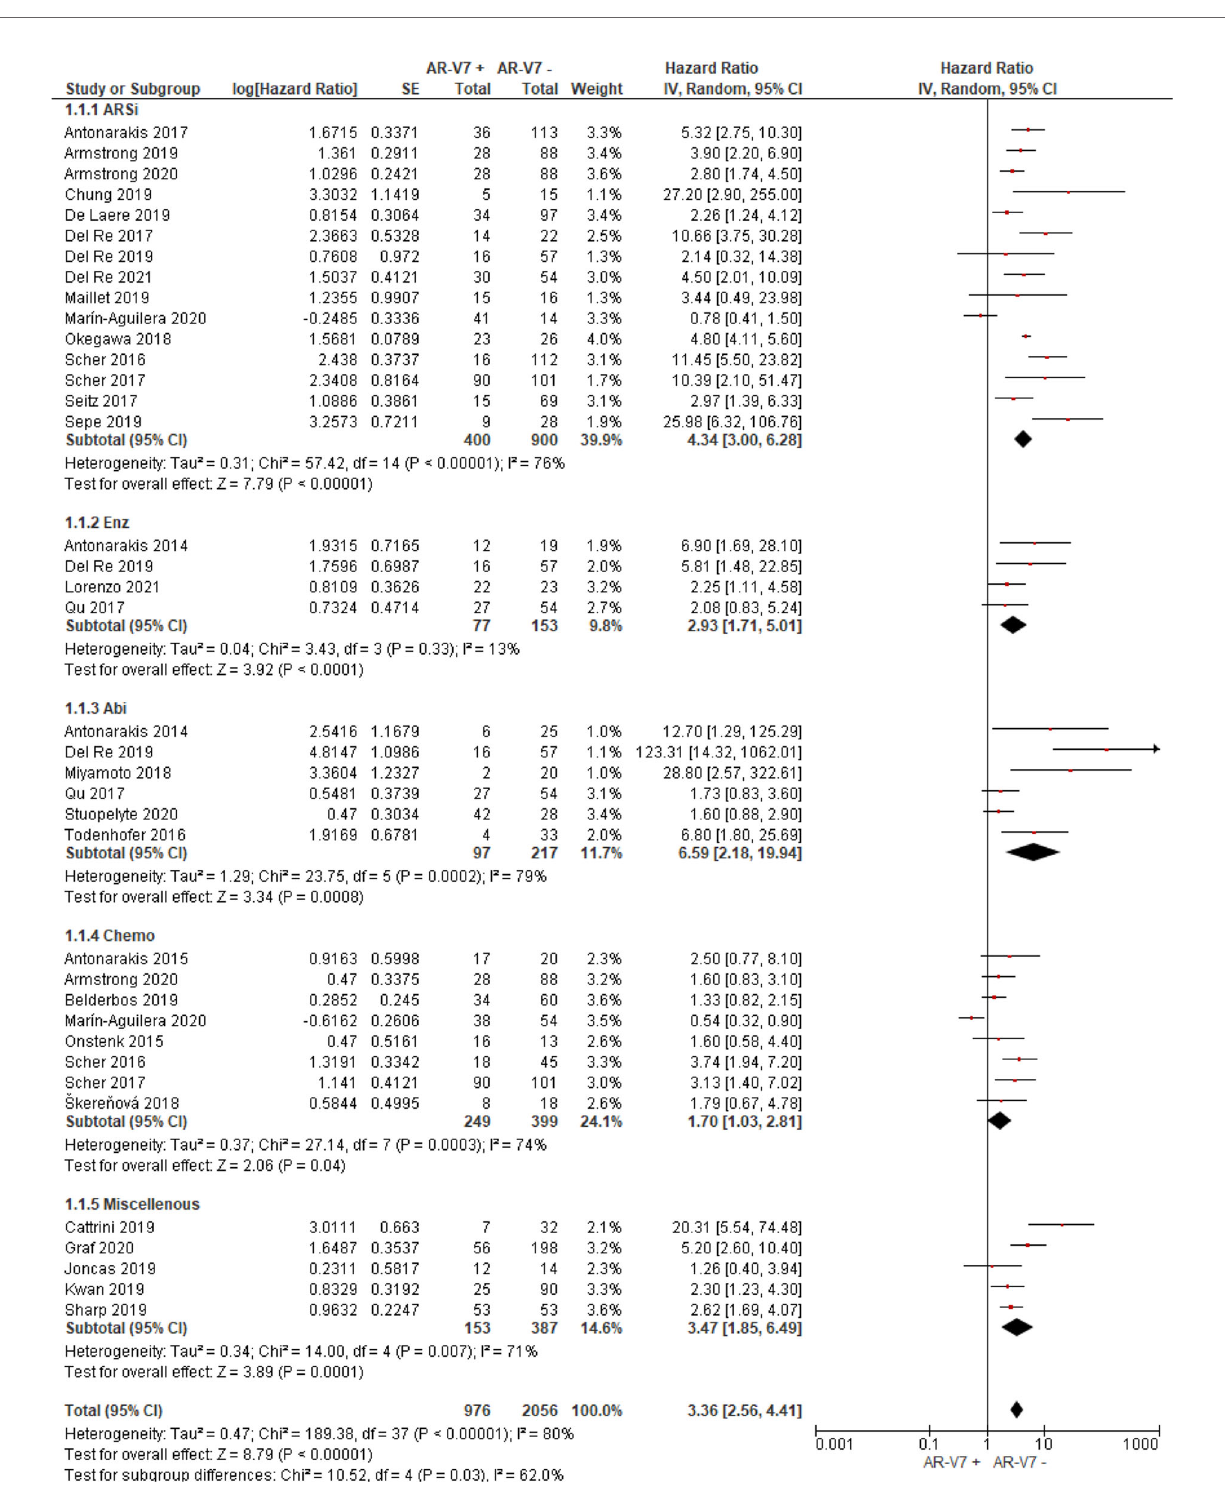
FIGURE 2 | Forest plot of hazard ratios (HRs) for association of liquid biopsy AR-V7 status with overall survival (OS) in all included studies. Pooled HRs were calculated using random effect model. AR-V7, androgen receptor splice variant 7; CI, con fi dence interval and bars indicate 95% CIs. Subgroup analysis (ARSi, enzalutamide or abiraterone; Enz, enzalutamide; Abi, abiraterone; Chemo, taxane based chemotherapy; Miscellaneous, treatments that do not belong to above treatments or not clearly de fi ned) were assessed.